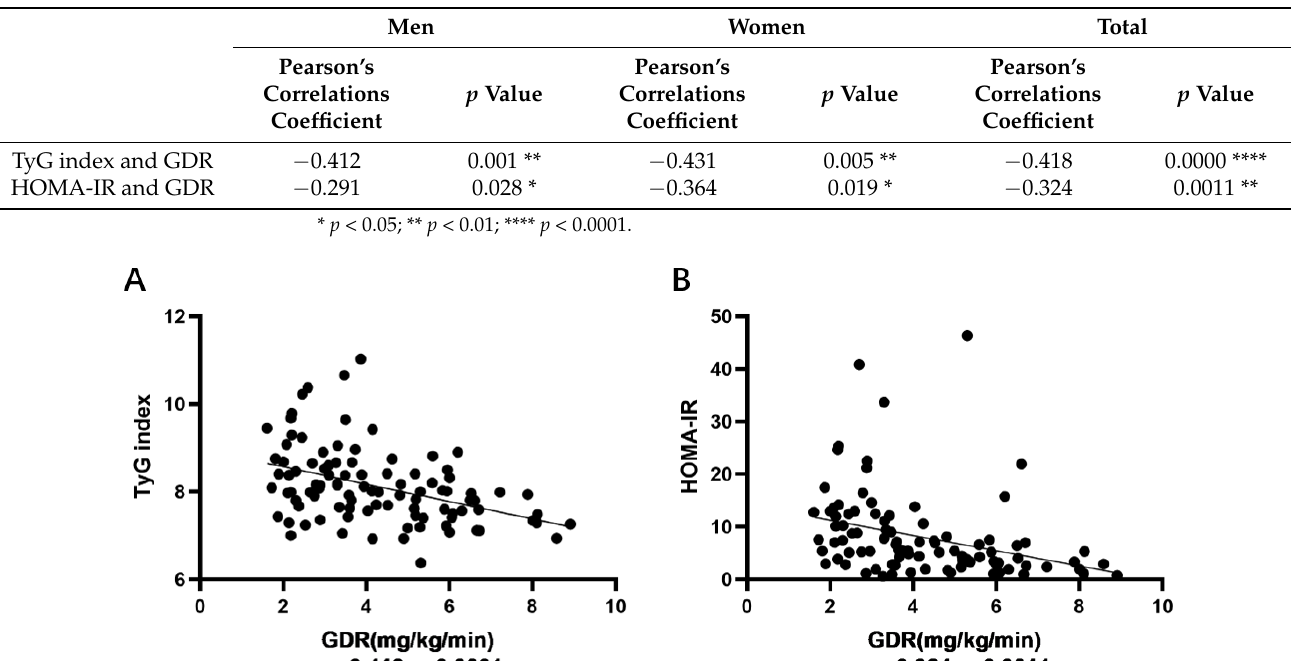
Table 2. Pearson ’ s correlations analysis between TyG index, HOMA-IR, and GDR. Table 2. Pearson’s correlations analysis between TyG index, HOMA-IR, and GDR.